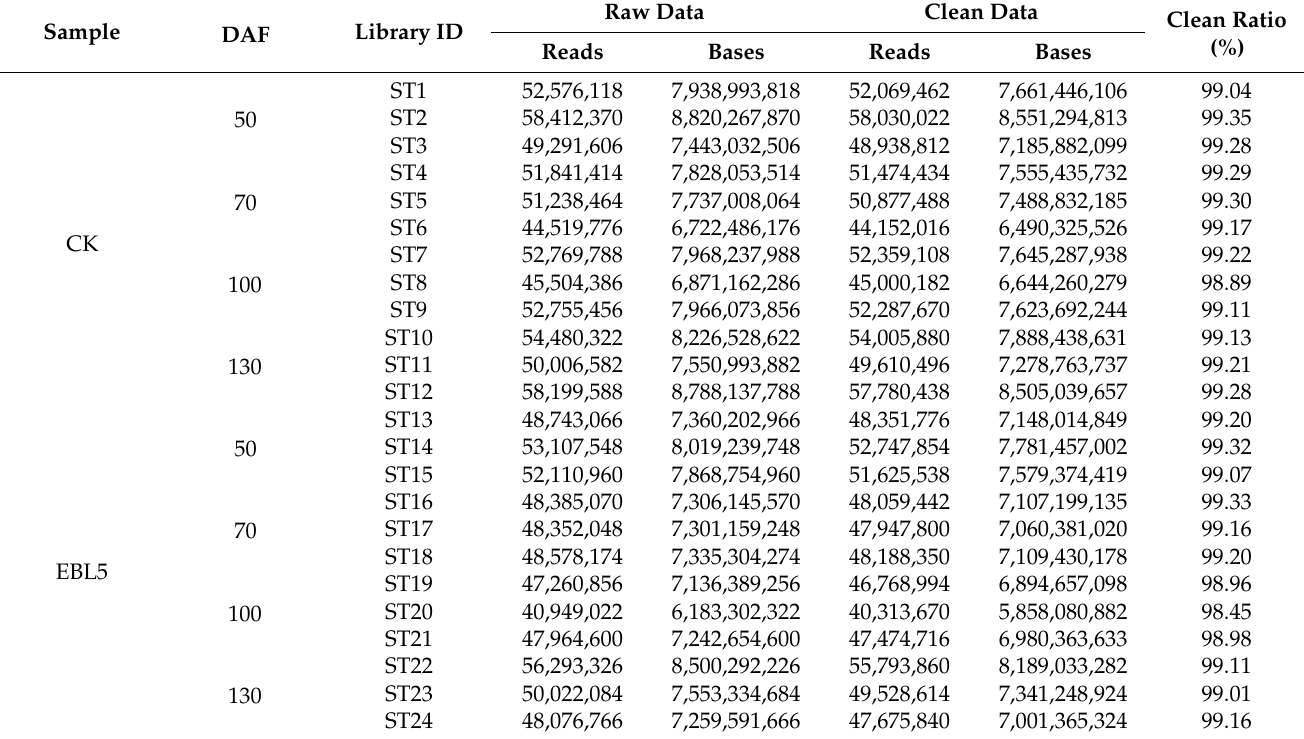
Table 1. Statistics of raw data and clean data.